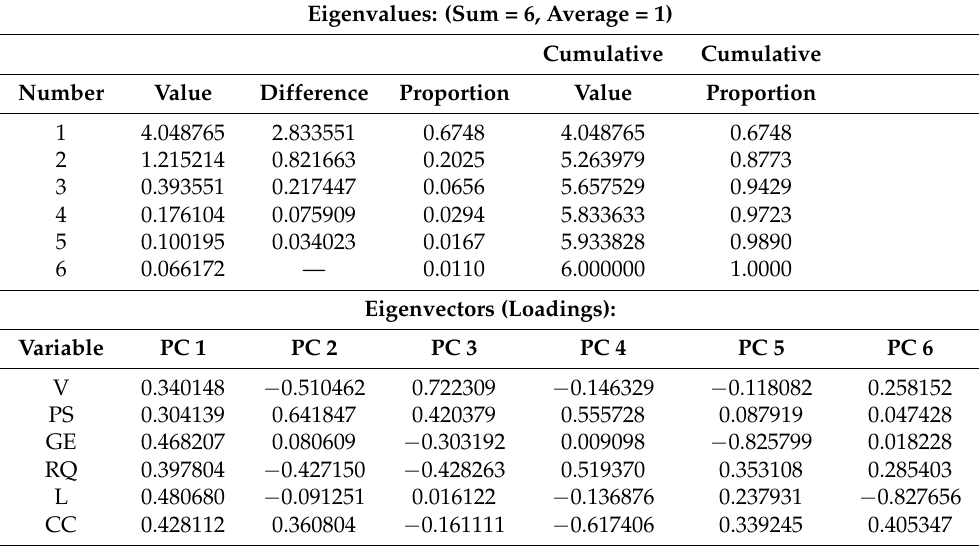
Table 4. Principle component